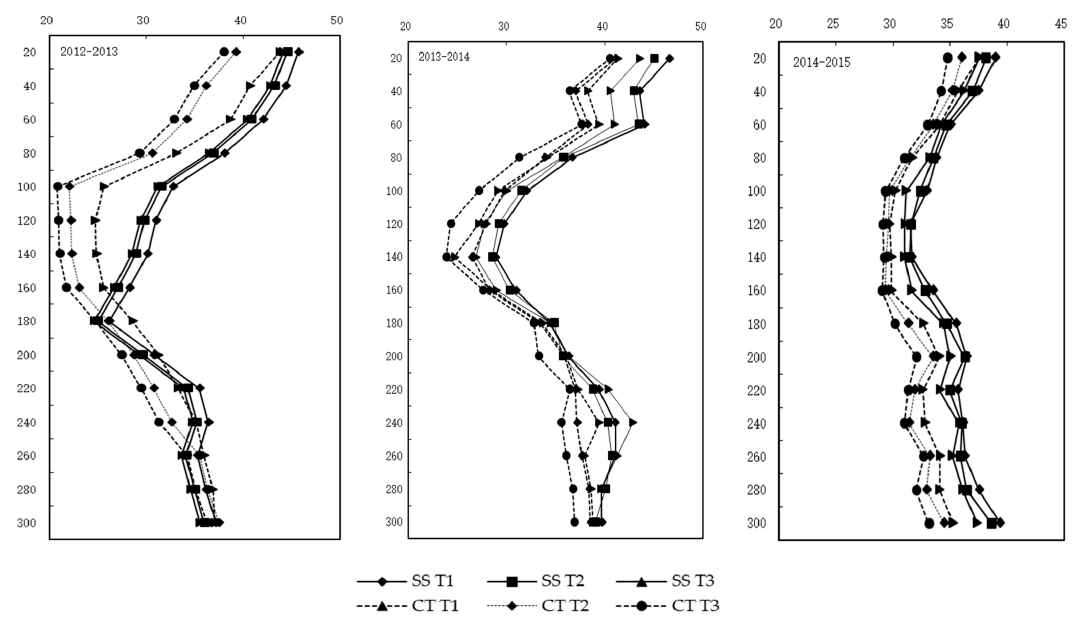
Figure 1. Effect of subsoiling and sowing date on soil water storage during 2012–2015. SS: Subsoiling during the fallow period; CT: Conventional tillage; T 1 : Early sowing date; T 2 : Timely sowing; T 3 : Late sowing. Values followed by different small letters indicate significant difference at 0.05 level.